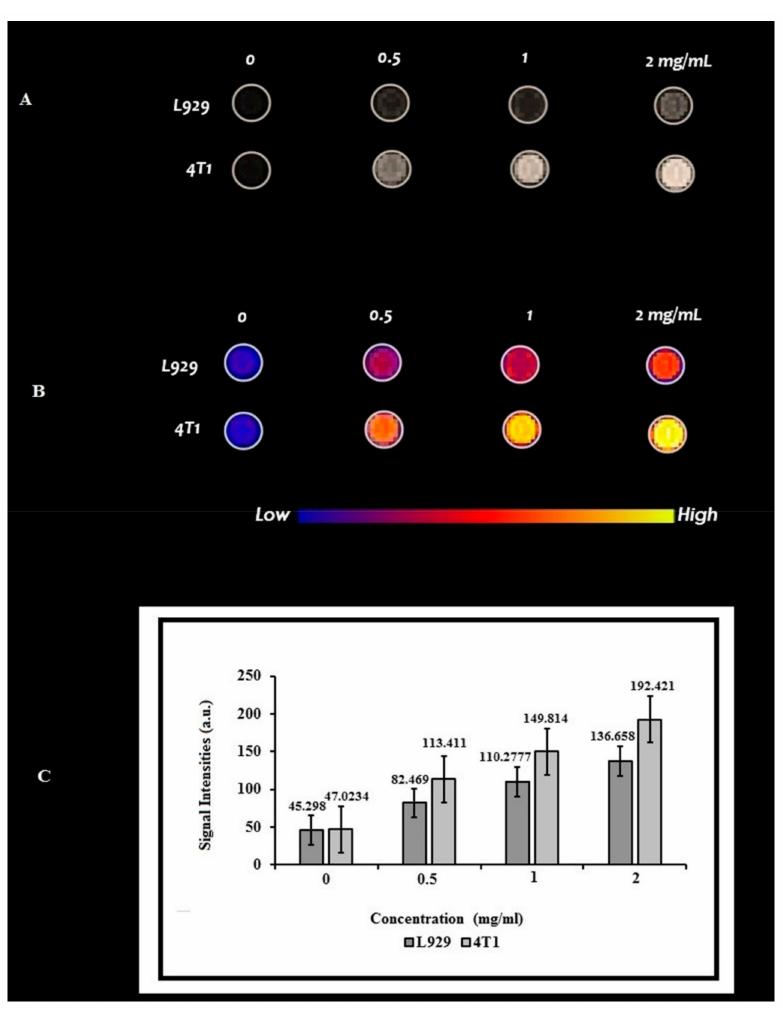
Figure 8. ( A ) MRI grayscale image of L929 and 4T1 at 0, 0.5, 1, and 2 mg/mL. ( B ) Color MR image of L929 and 4T1 at 0, 0.5, 1, and 2 mg/mL. ( C ) Comparison of signal intensity between 4T1 and L929